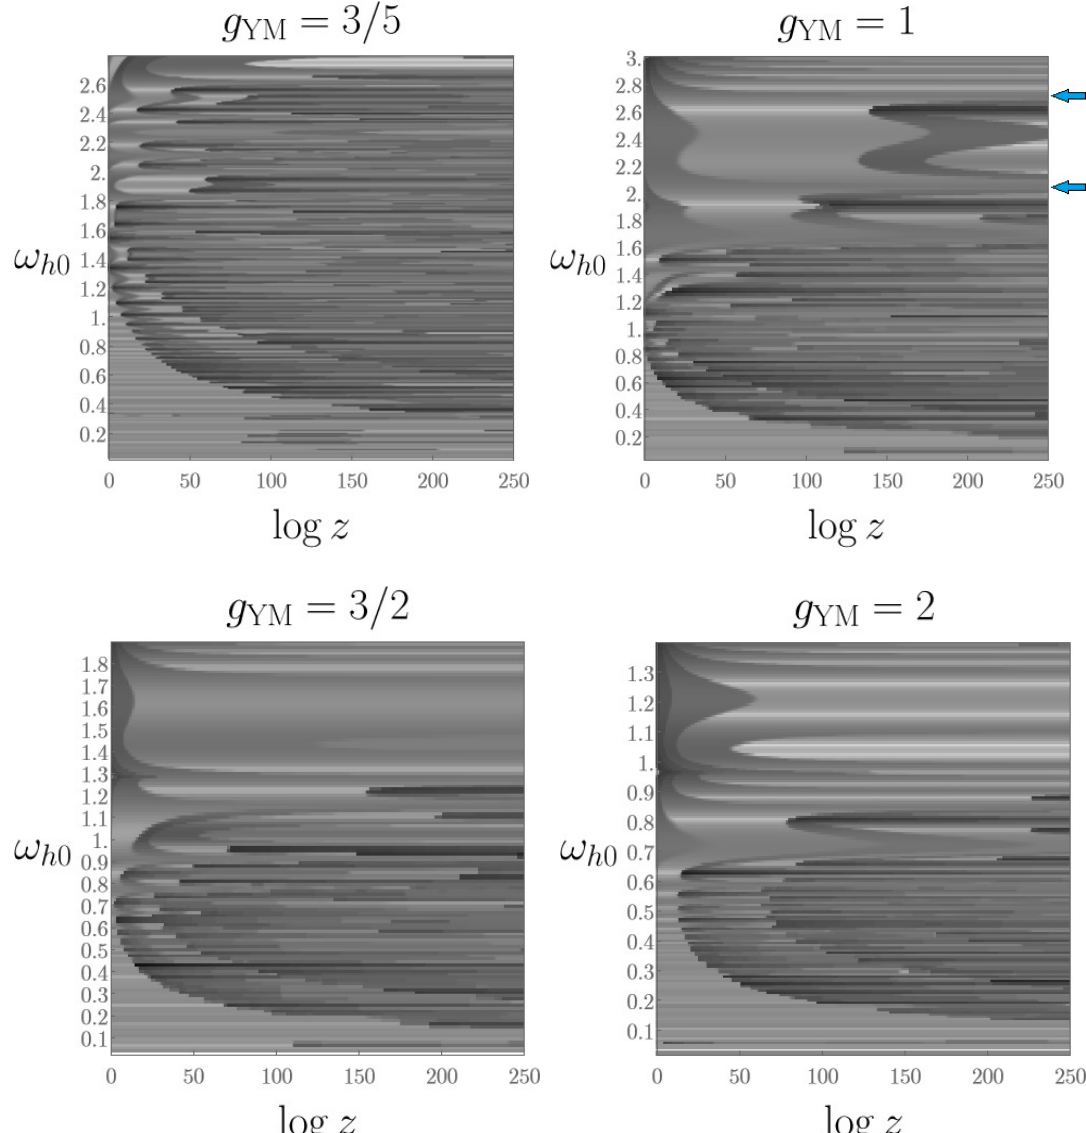
Figure 15. Density plots for function zχ 0 at the four values of g YM : 3 / 5 , 1 , 3 / 2 and 2 . The chaotic nature at small ω h 0 (and correspondingly, high temperatures) is visible, while more structure arises at larger ω h 0 choices. Particular values of ω h 0 correspond to critical points, denoted by the blue